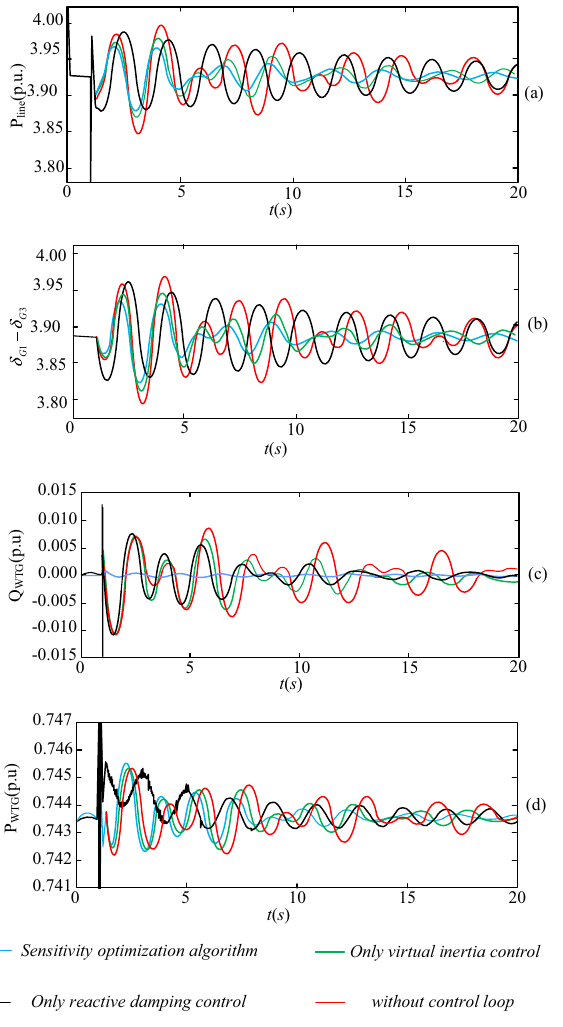
Figure 12. Power across the contact line after a